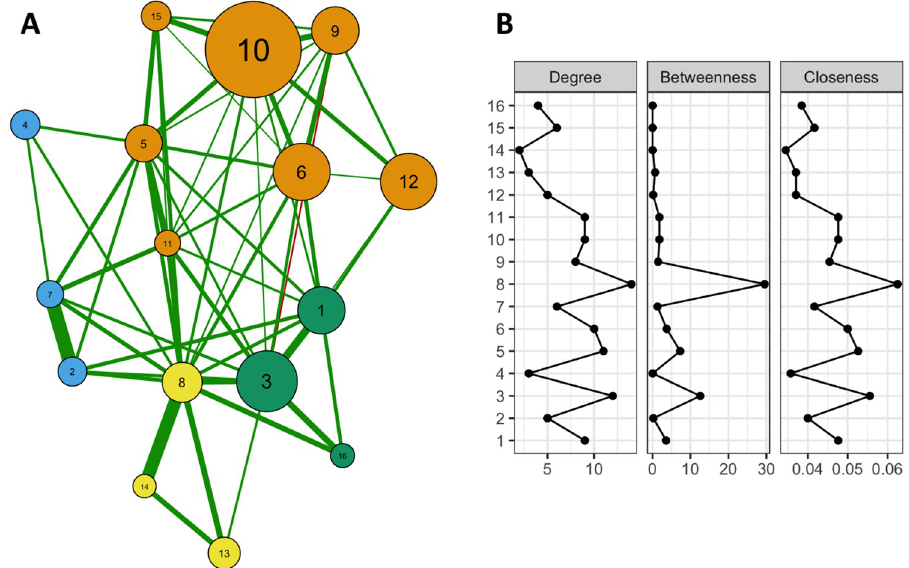
Fig 1. Morbidity network in Brazilian older adults. National Health Survey (PNS-Brazil, 2013). (A) The graph depicts the analysis network. The nodes represent each morbidity in the model, and the edges connecting the nodes represent the effect size for the association between nodes. Green and red edges represent positive and negative connections, respectively. The colors of the nodes correspond to the clusters detected in the network. (B) Network centrality measurements (degree, betweenness, closeness). Morbidities: 1- arthritis/rheumatism; 2- asthma/bronchitis, 3- back pain; 4- cancer; 5- heart disease (myocardial infarction, heart failure, or cardiac arrhythmias), 6- hypercholesterolemia, 7- chronic obstructive pulmonary disease (COPD); 8- depression, 9- diabetes; 10- hypertension; 11- kidney disease; 12- obesity; 13- other chronic diseases; 14- mental illnesses other than depression; 15- stroke; 16- work-related musculoskeletal